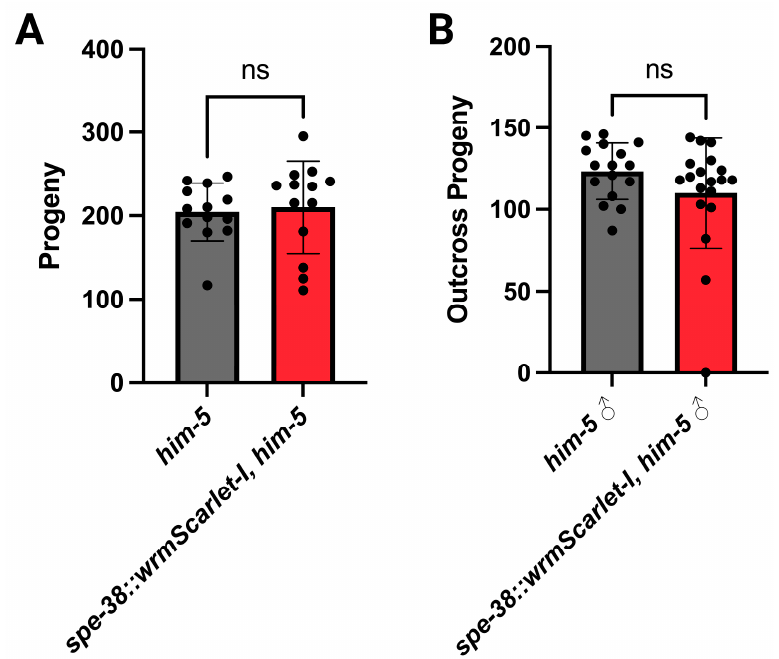
Figure 2. The fertility of genome edited hermaphrodites ( A ) and males ( B ). The fertility of hermaphrodites and males expressing SPE-38::wrmScarlet-I are not significantly different from non-genome edited controls. In all experiments n > 10 animals. The gray (wild-type) and red (genome edited) histogram bars represent the average number of progeny produced. Black dots represent the brood counts for individual hermaphrodites ( A ) or outcross progeny produced ( B ). Error bars represent the standard deviation (SD). For hermaphrodite and male fertility, two-tailed unpaired Student’s t -test, p > 0.05 indicates not signi fi cant (ns).